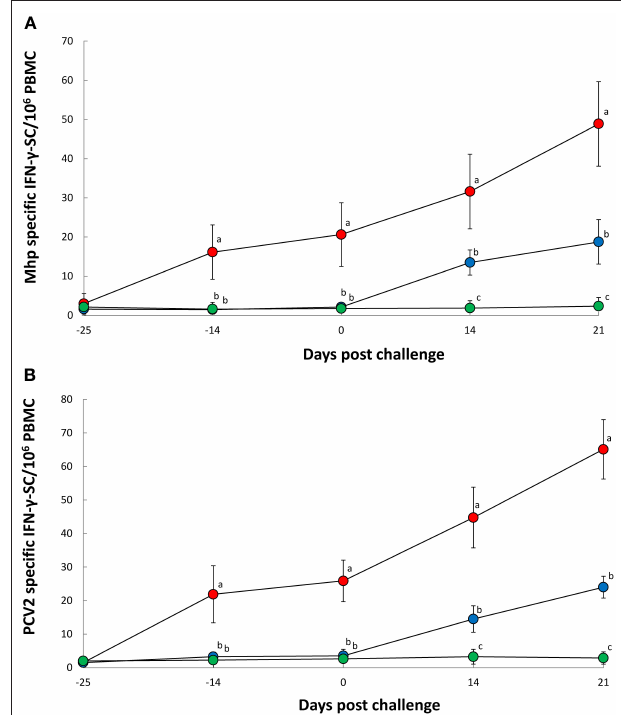
FIGURE 3 | Frequency of Mycoplasma hyopneumoniae -specific interferon- γ secreting cells (IFN- γ -SC) (A) and porcine circovirus type 2b-specific IFN- γ -SC (B) in peripheral blood mononuclear cells (PBMC) from Vac/Ch ( ), UnVac/Ch ( ), and UnVac/UnCh ( ) groups. Variation is expressed as the standard deviation. Different superscripts (a, b, and c) indicate significant ( P < 0.05) difference among three groups.